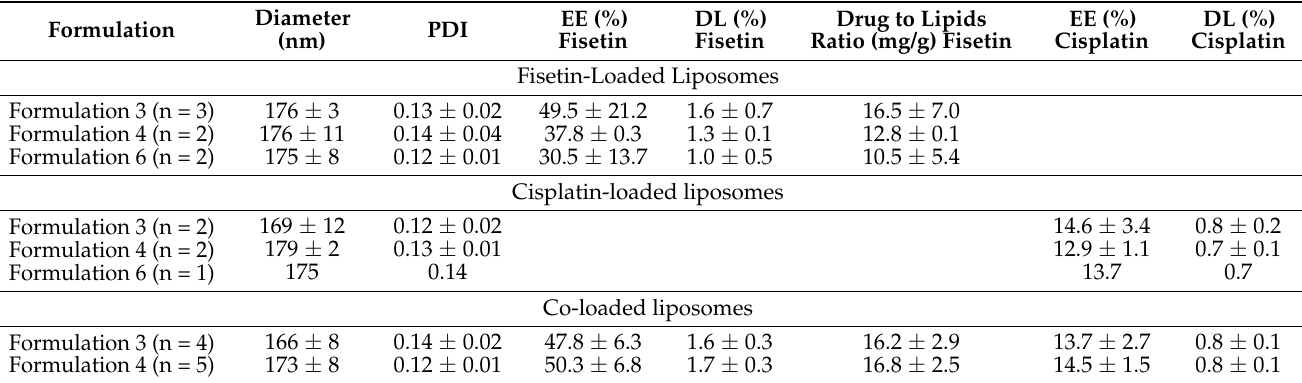
Table 2. Size, PDI and drug encapsulation of fisetin-loaded, cisplatin-loaded and fisetin and cisplatin-co-loaded liposomes (mean ±